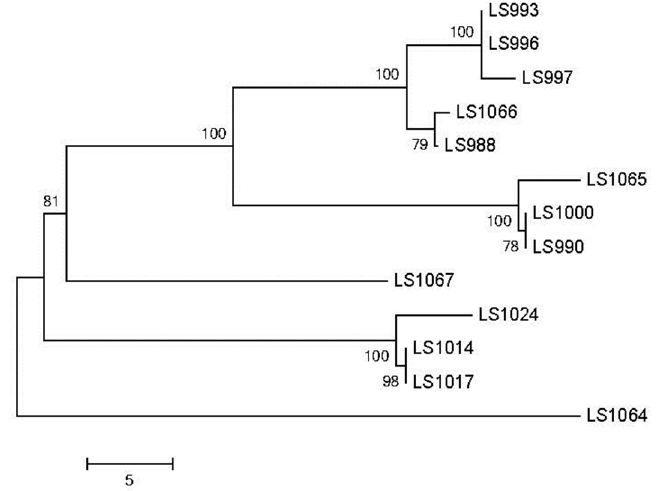
Fig 2. An optimal tree focusing on cluster 3 containing the stone fruit and apple 4bV isolates. The tree was generated as in Fig 1 with a sum of branch length = 129.46875000 is shown. The percentage of replicate trees in which the associated taxa clustered together in the bootstrap test (1000 replicates) are shown next to the branches [32]. The tree is drawn to scale, with branch lengths in the same units as those of the evolutionary distances used to infer the phylogenetic tree. The evolutionary distances were computed using the number of differences method [33] and are in the units of the number of base differences per sequence. The analysis involved 13 nucleotide sequences. Codon positions included were 1st+2nd+3rd+Noncoding. All ambiguous positions were removed for each sequence pair. There were a total of 23545 positions in the final dataset. Evolutionary analyses were conducted in